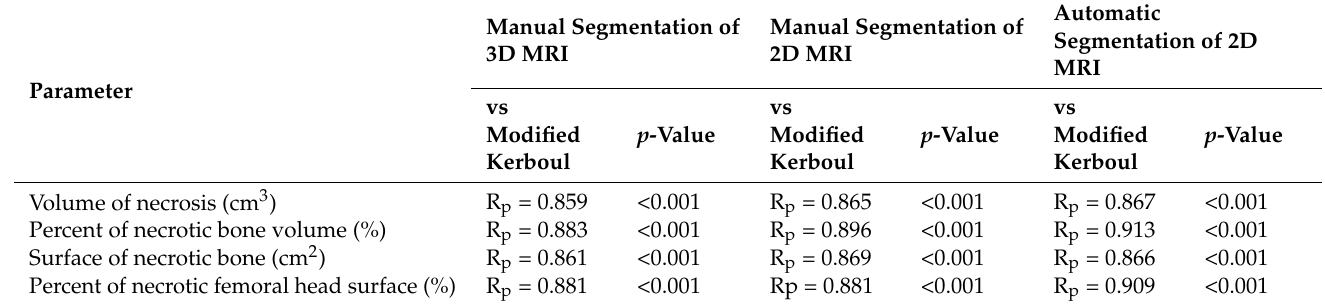
Table 6. Correlations between the manual segmentation of 3D and 2D MRI and automatic segmenta- tion of 2D MRI against the modified Kerboul